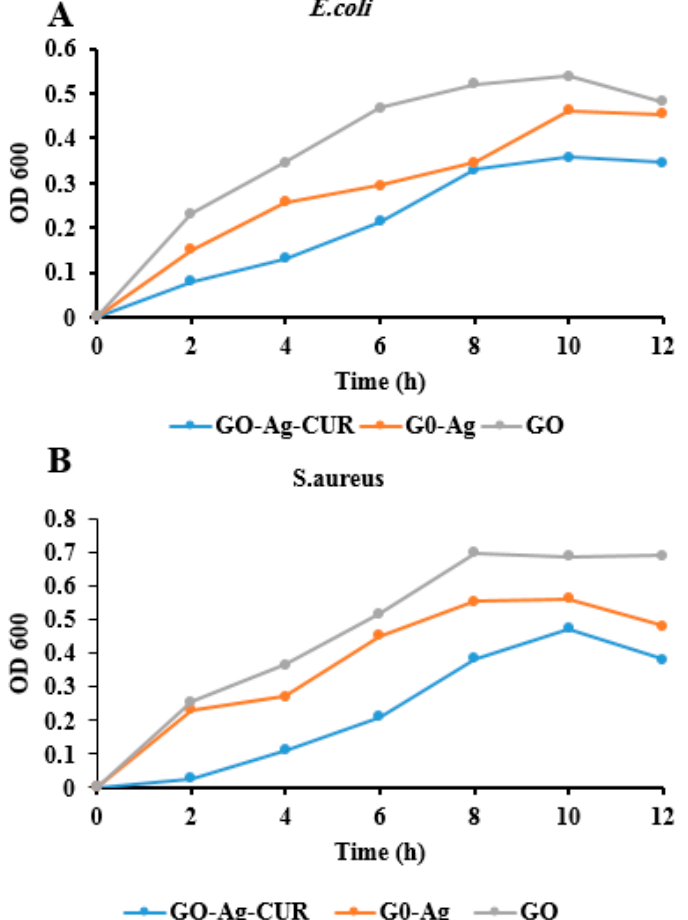
Figure 8. OD measurement of ( A ) E.coli and ( B ) S. aureus for MIC concentration of GO, GO-Ag, and GO-Ag-CUR. Table 6. CUR loading and encapsulation efficiencies in GO and